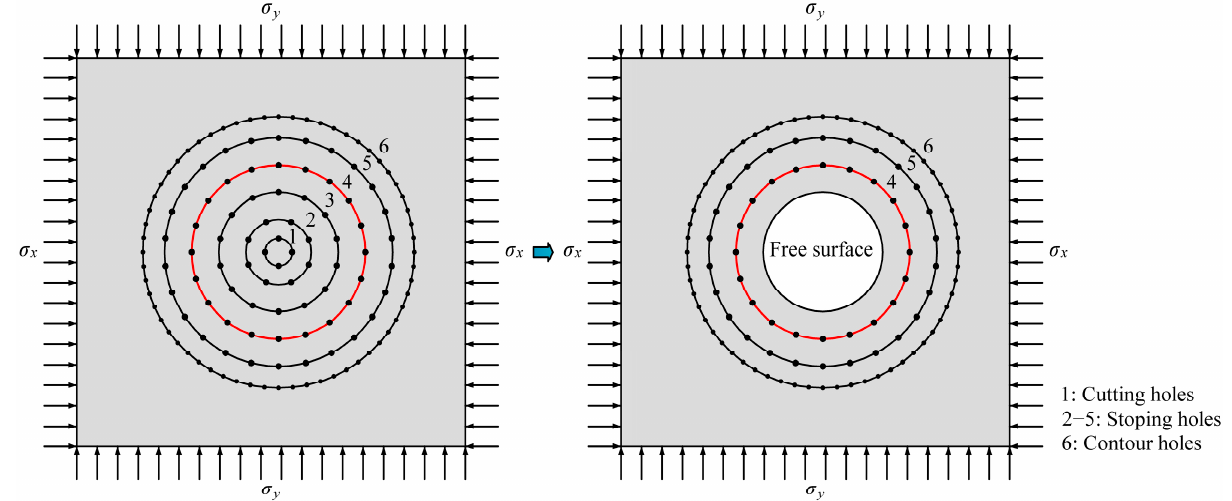
Figure 1. Conceptual model of multiple-hole blasting under in situ stress.